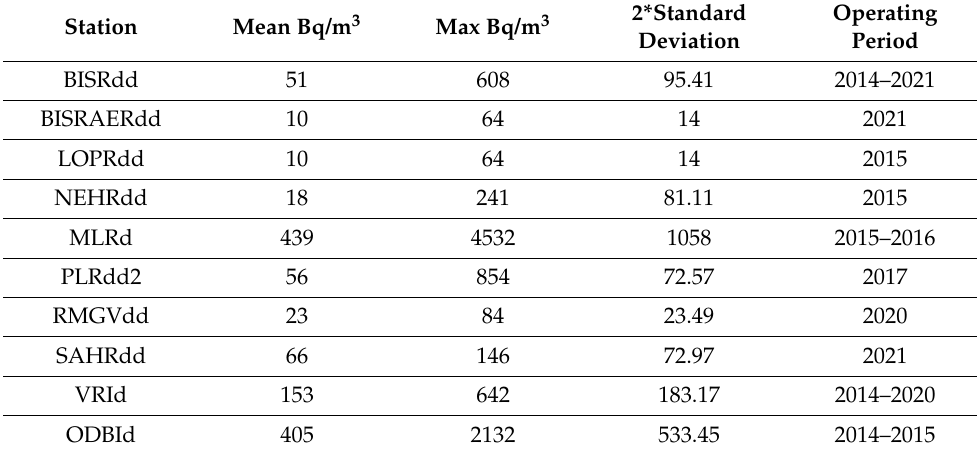
Table 2. Statistics of radon